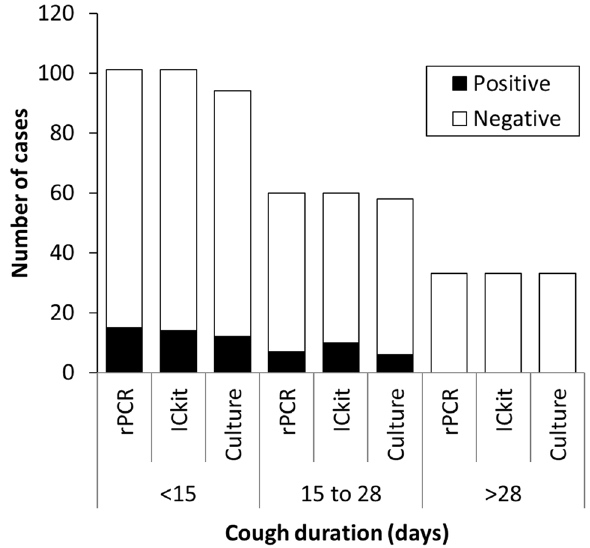
Figure 4. The results of rPCR, the ICkit, and culture by cough duration groups. A total of 194 cases with cough were analyzed. Of them, nine cases were tested by the ICkit and rPCR, but not tested by culture. ICkit immunochromatographic antigen kit, rPCR real-time polymerase chain